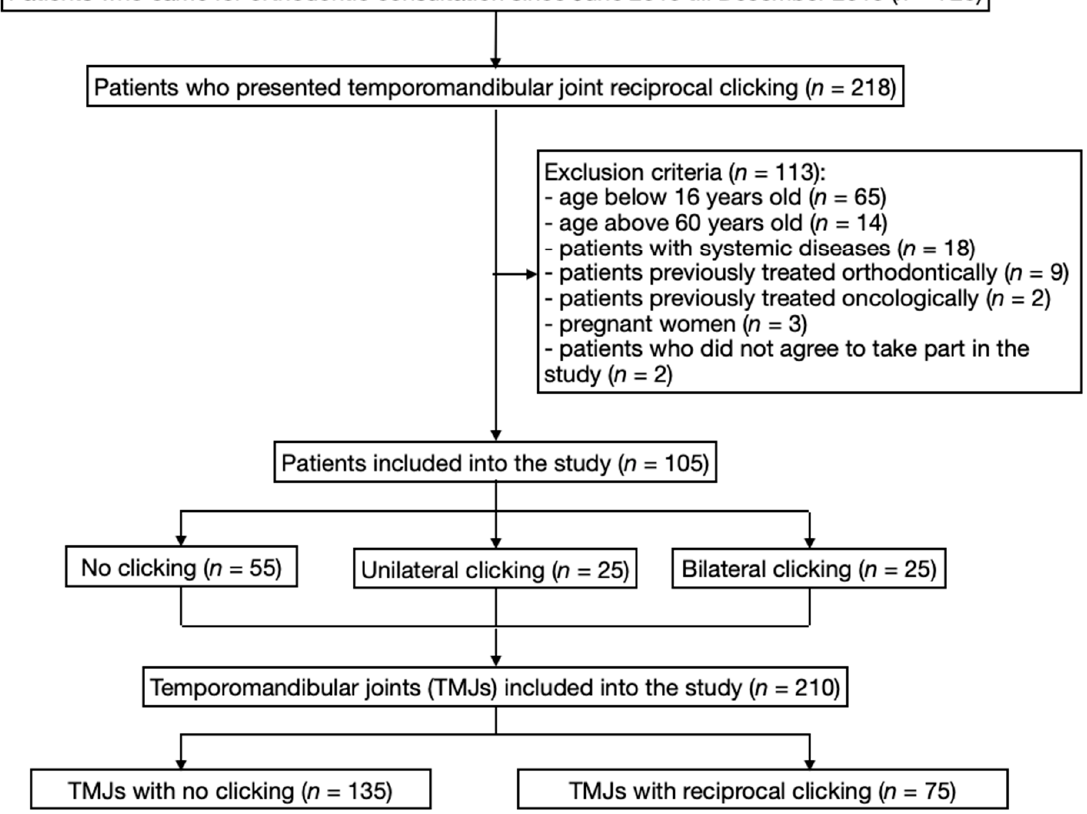
Figure 1. The flow chart of participation.